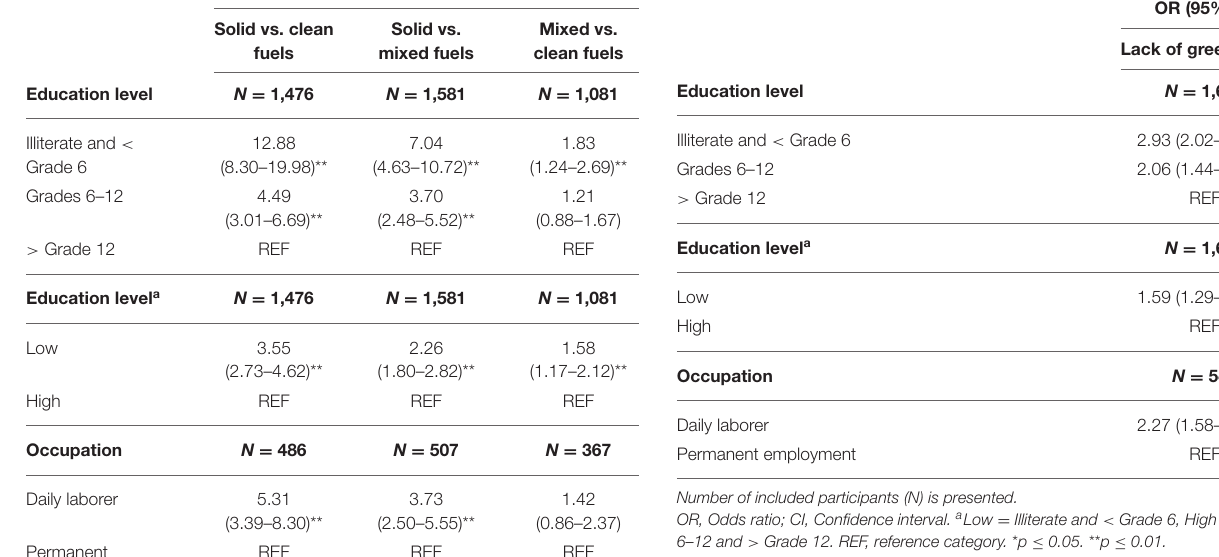
TABLE 5 | Odds of experiencing a lack of green space in the residential area TABLE 4 | Odds of using solid fuels for cooking associated with education level associated with education level and occupation among women in the Adama and occupation among women in the Adama Mother and Child cohort. Mother and Child OR (95% CI) Solid vs. clean Solid vs. fuels mixed fuels